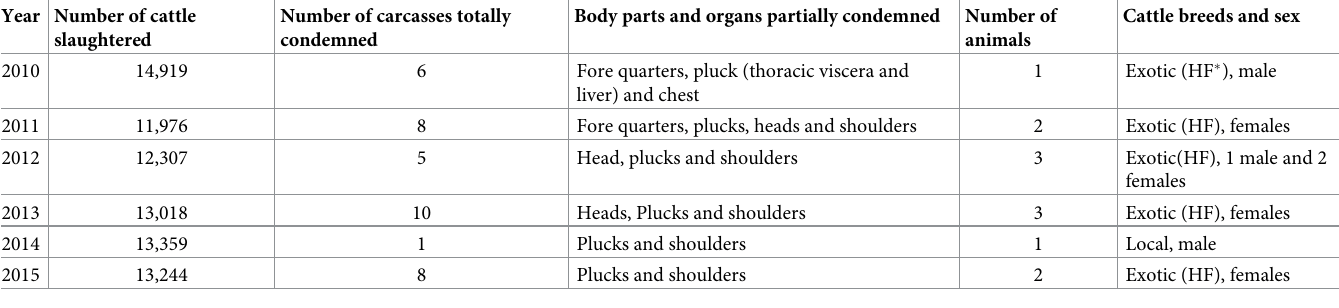
Table 2. Total number of cattle slaughtered, and number of totally and partially condemned carcasses and organs due to the presence of tuberculosis-like lesions (TBL) from 2010 to 2015 (inclusive) at Asmara municipal slaughterhouse in Eritrea. Year Number of cattle